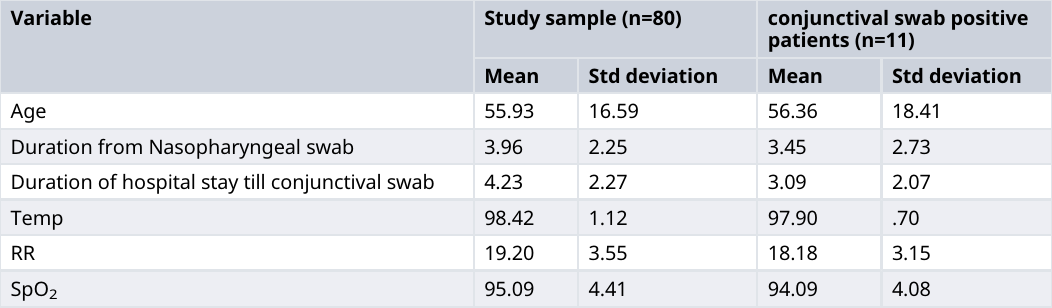
Table 1. Descriptive statistics for continuous variables for the whole sample and conjunctival swab positive